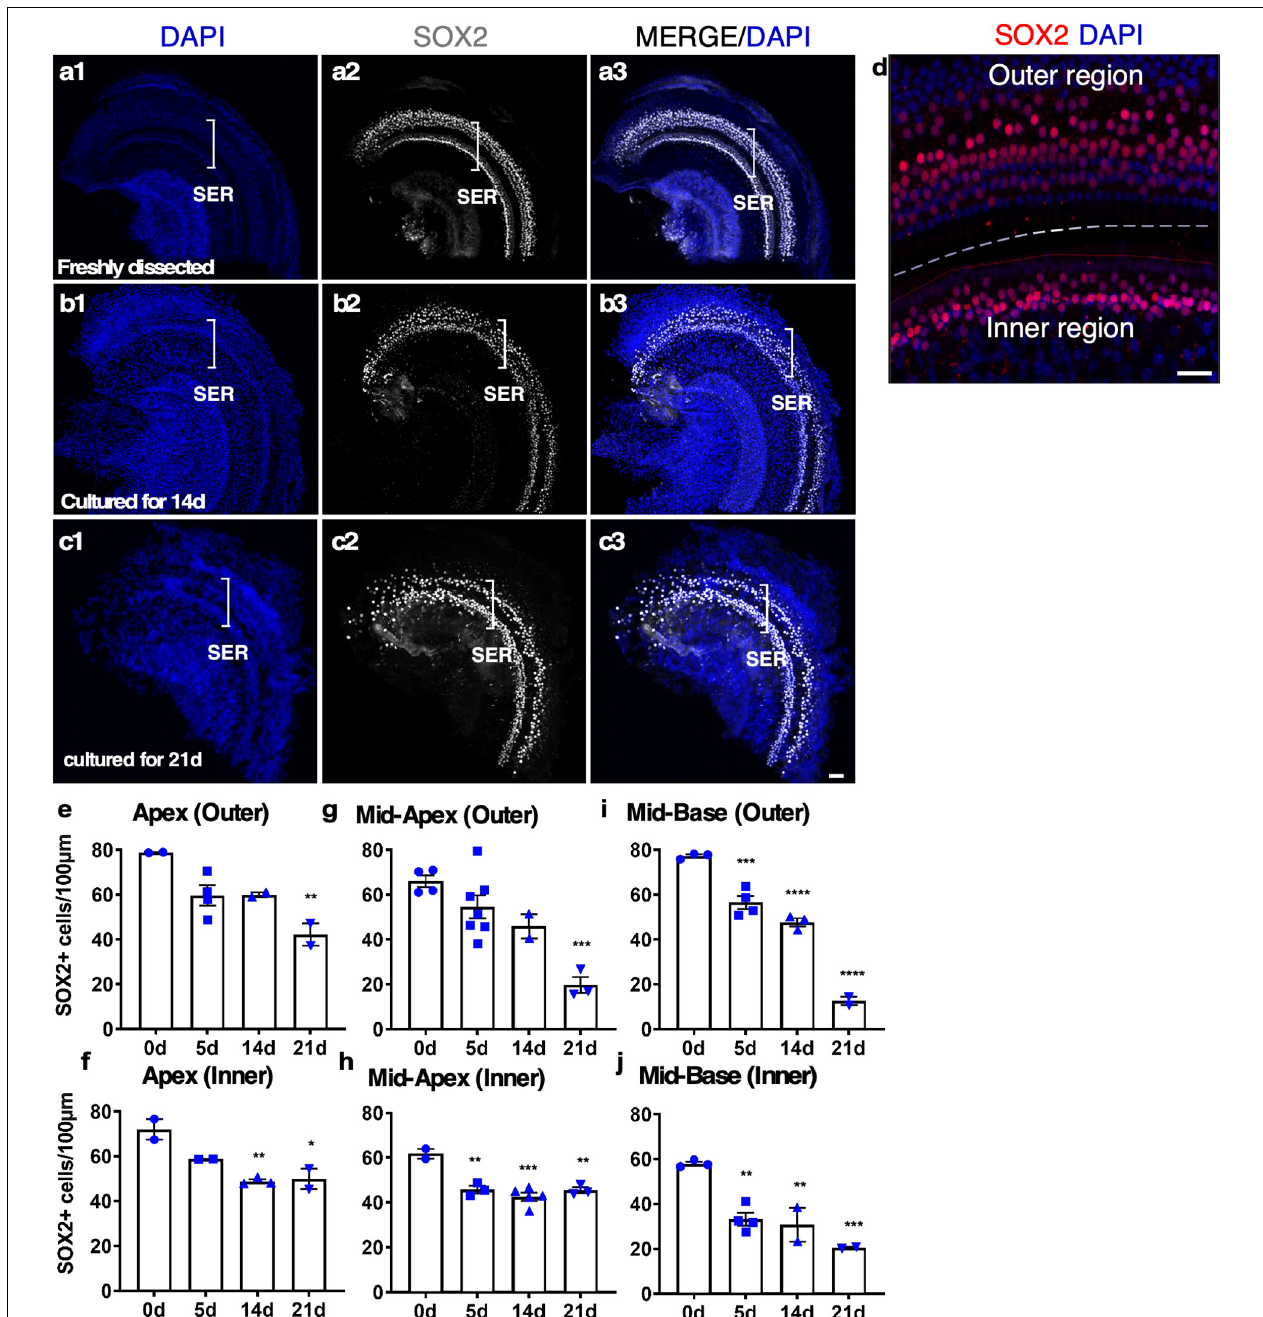
FIGURE 3 | The survival of SOX2 + supporting cells (SCs) in adult cochlear explant culture. (a–c) Fresh and cultured wild-type adult cochlea (apex). (a1–a3) In a freshly dissected adult cochlea labeled with an anti-SOX2 antibody, SOX2 + SCs were confined to the sensory epithelial region (SER, bracket). (b1–b3) After 14 days in culture, the overall structure of the organ of Corti was intact with the survival of most of the SCs. (c1–c3) By 21 days, the loss of SOX2 + SCs became apparent yet the organ of Corti structure was maintained. (d) A freshly dissected sample to show the SCs in the inner and outer hair cell regions. (e–j) Quantification of SCs in the outer and inner SER ( d , demarcated by a dashed line) along the cochlear turns showed similar patterns of survival of SCs in the apex and mid-turns for up to 14 days, and a diminished number of SCs in the base at 21 days in culture. * p < 0.05, ** p < 0.01, *** p < 0.001, **** p < 0.0001. One-way ANOVA comparison of the data obtained on days 5, 14, and 21 with the data obtained day 0. Error bar, mean ± SEM, n = 2–7 in each group. n is the number of biologically independent cochlea samples. Scale bars: 50 µ m.